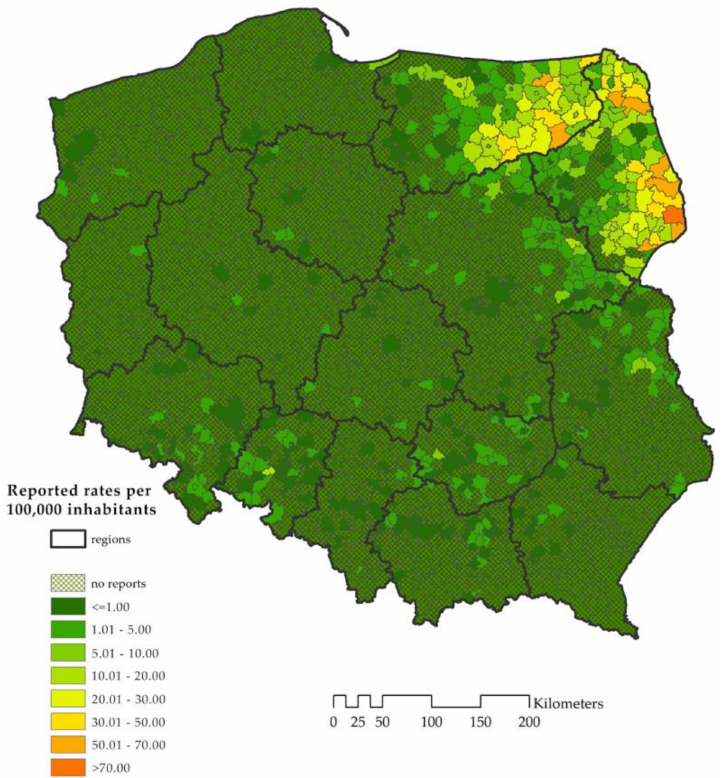
Figure 1. TBE reported rates by NUTS-5 administrative units, Poland,